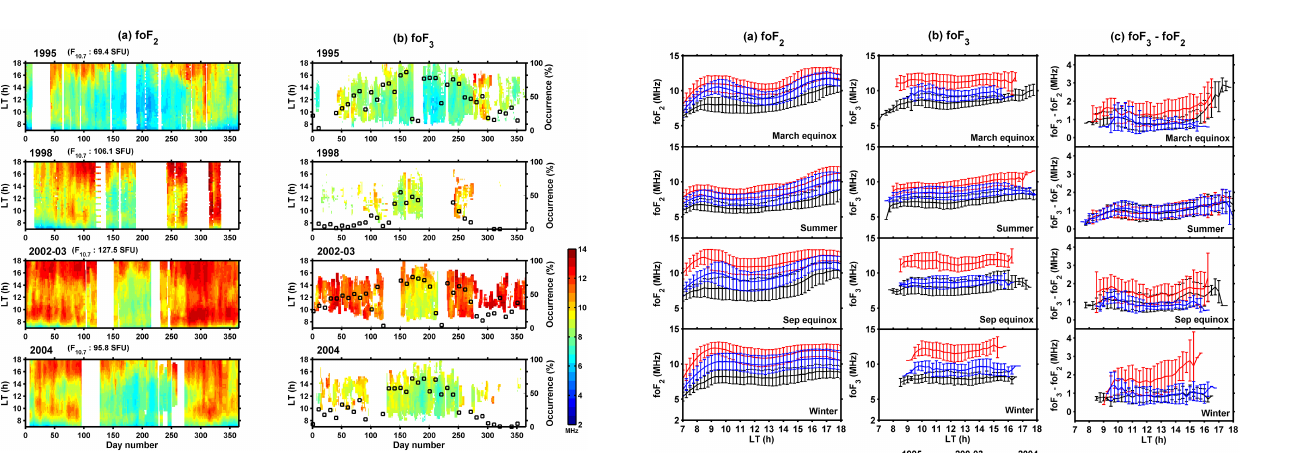
Figure 2. Local time variations in the mean and SD of (a) f o F 2 , (b) f o F 3 and (c) f o F3– f o F2 in different seasons and differ- ent solar activity conditions. Results presented in red, blue and black correspond to 2002–2003 ( F 10 . 7 >125sfu), 2004 (125sfu > F 10 . 7 >75sfu) and 1995 ( F 10 . 7